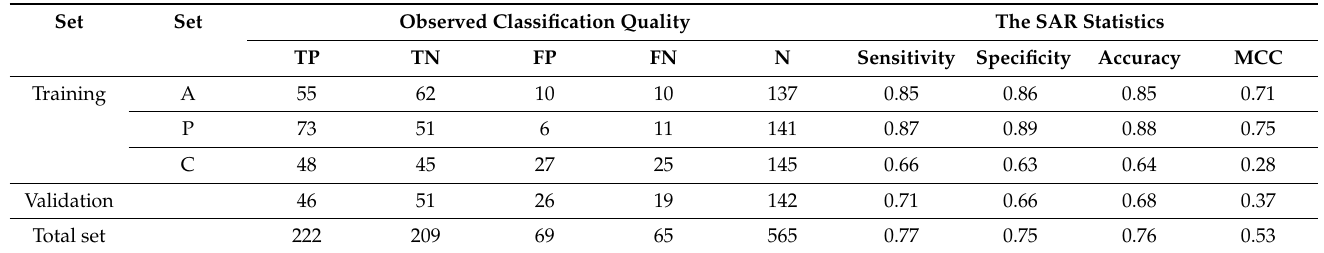
Table 2. The statistical quality of model observed for the first optimal descriptor with the first version of the Monte Carlo optimisation of the correlation weights.